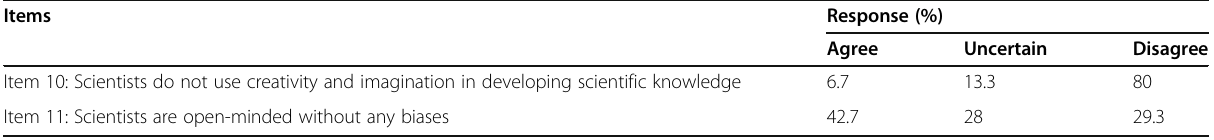
Table 5 Perceptions of the NOS: Scientist ’ s Work ( N = 225)